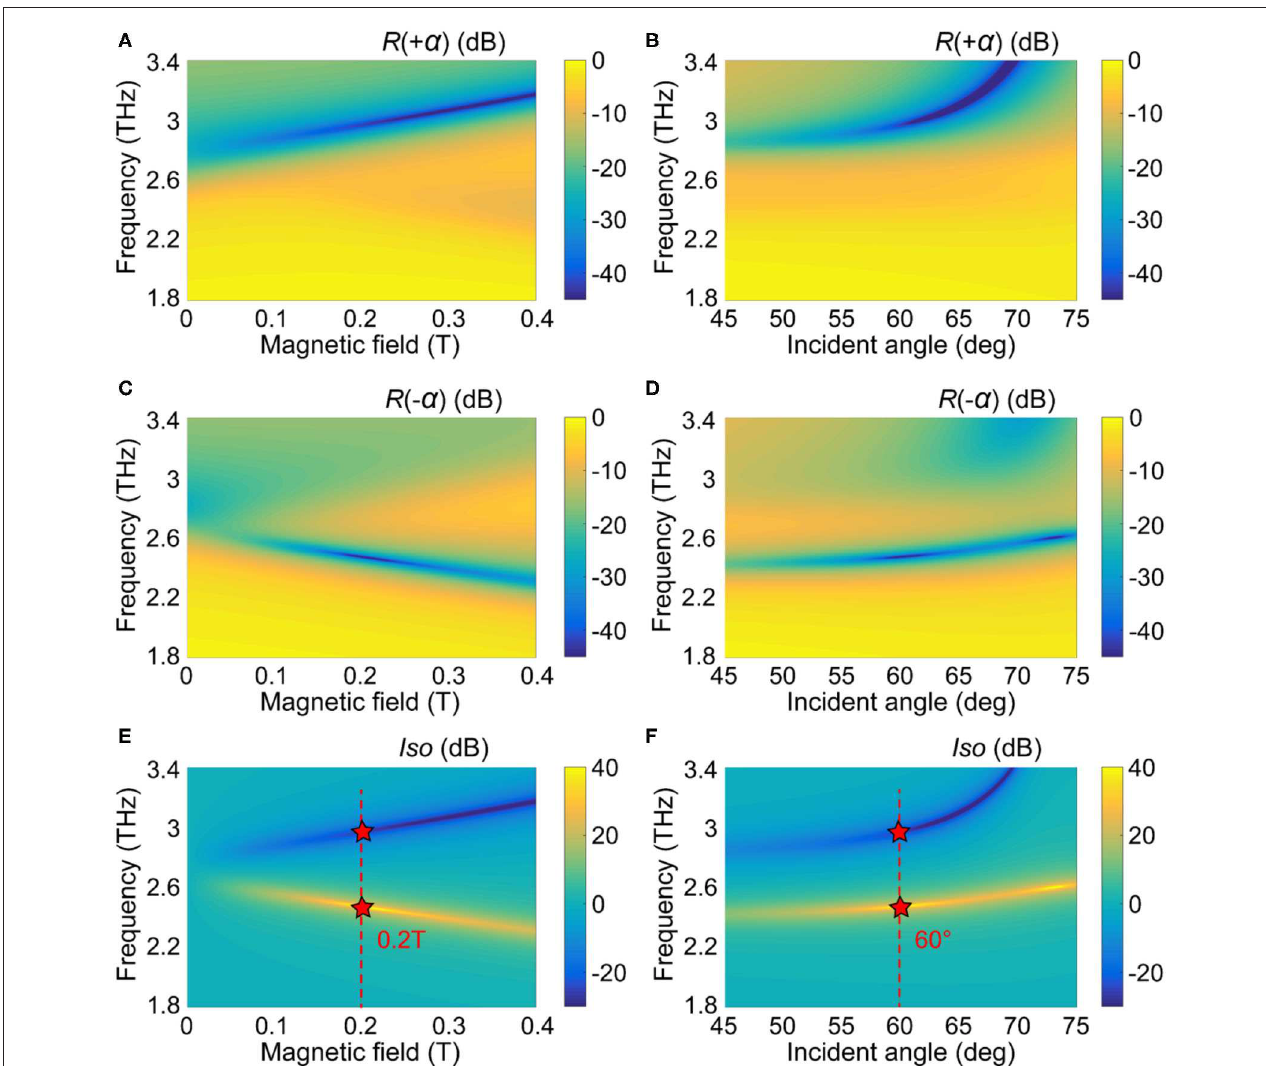
α) (A) and backward wave R ( α) (C) , and the isolation Iso (E) for the InSb wafer with the different external + − α) (B) and backward wave R ( α) (D) , and the calculated 60 ◦ . The calculated reflections of the forward R ( = + − =